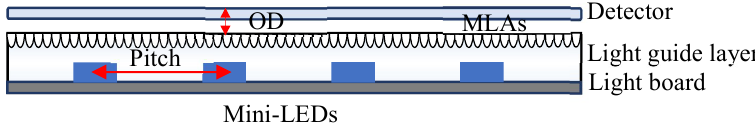
Figure 7. Calculation of the uniformity merit function. OD, optical distance.